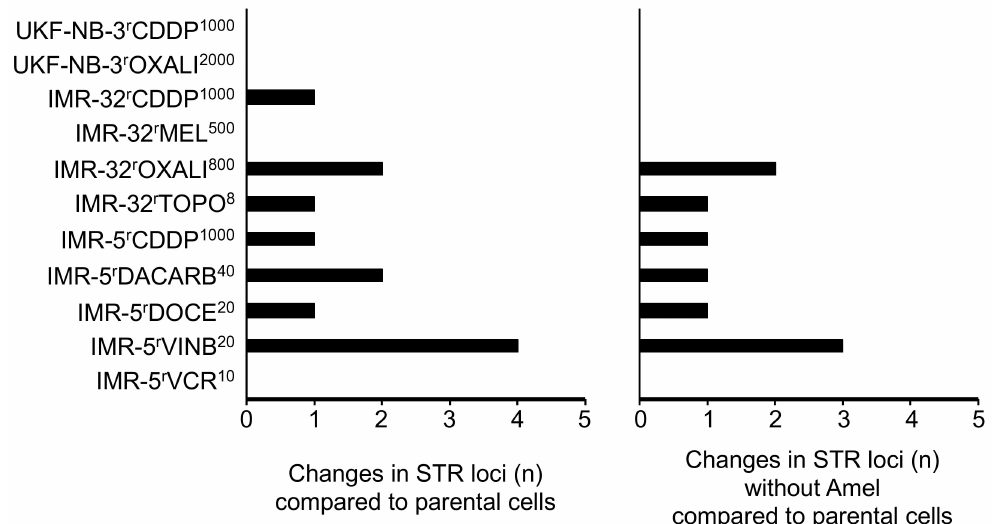
Figure 1. Numbers of STR (short tandem repeat) loci in which drug-adapted sublines di ff er from the respective parental cell lines with or without the amelogenin locus (Amel) that discriminates between the X and the Y chromosome.